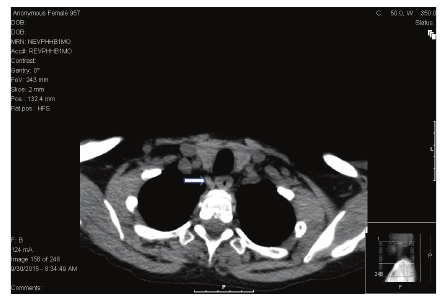
Figure 4: CT scan of the neck without contrast showing a soft tissue mass posterior to mid pole of the right thyroid lobe (denoted by arrow).